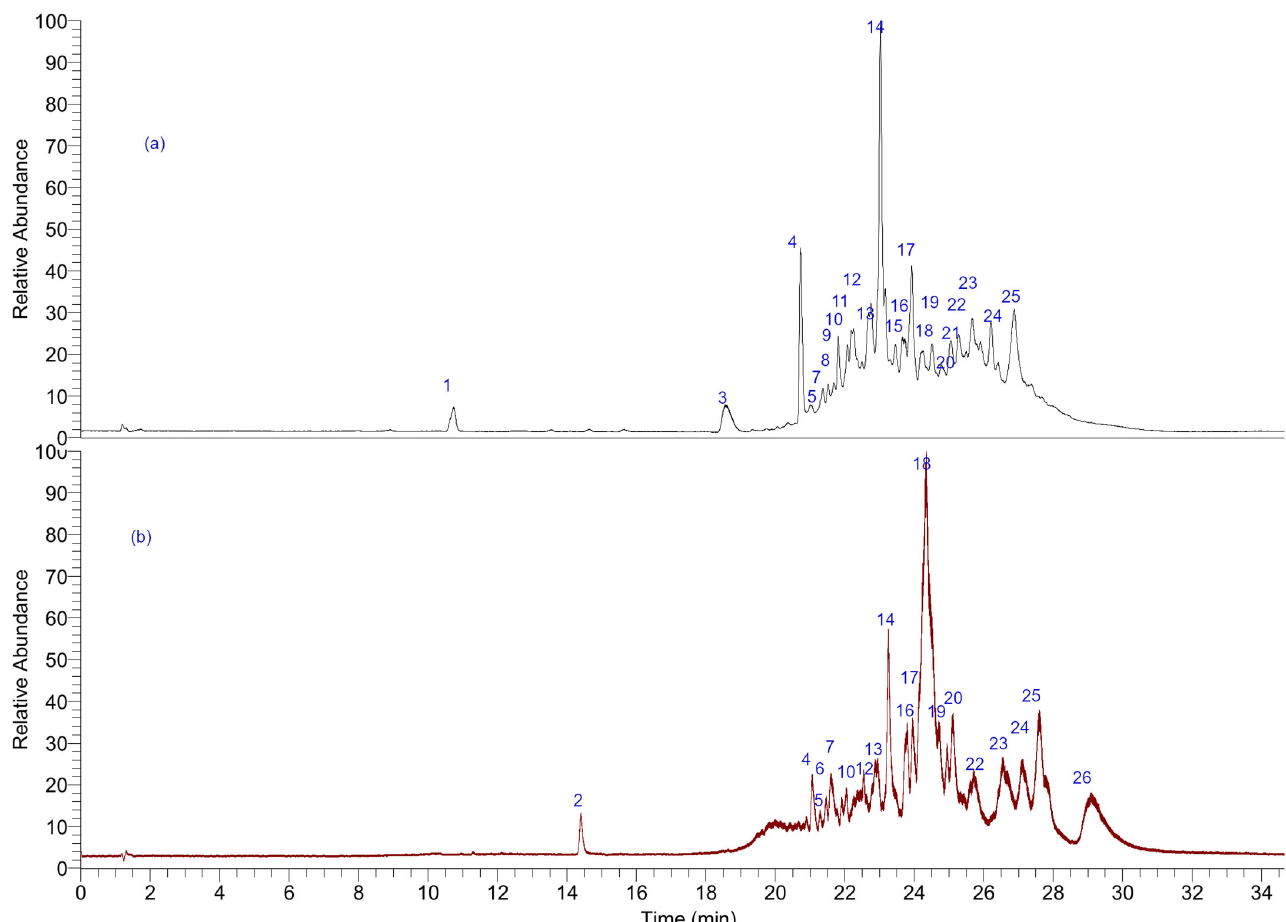
Figure 2. UHPLC ‐ DAD chromatogram of G. pinifolium Phil. ( a ) ethyl acetate extract ( b ) n ‐ hexane Figure 2. UHPLC-DAD chromatogram of G. pinifolium Phil. ( a ) ethyl acetate extract ( b ) n -hexane extract. The peak numbers correspond to those identified in Table 1. extract. The peak numbers correspond to those identified in Table